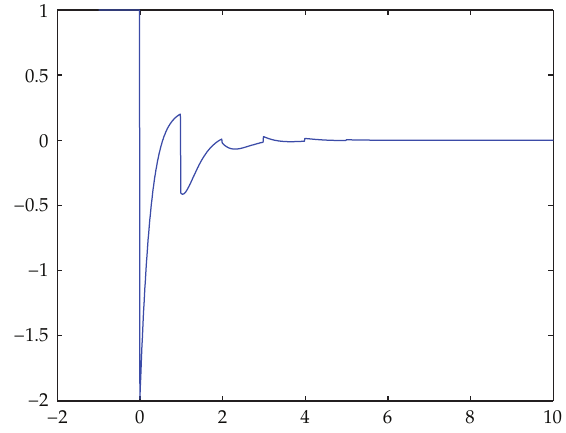
Figure 3: The numerical solution of (cid:3) 4.1 (cid:4) , when (cid:3) 3.1 (cid:4) is the implicit Euler method as h (cid:7) 1 /